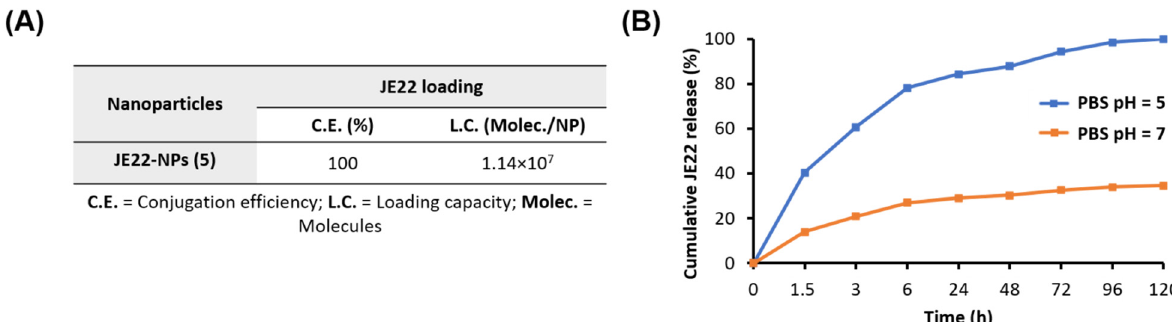
Figure 4. Evaluation of drug loading and release from JE22-NPs ( 5 ). ( A ) Determination of CE and LC of JE22 per nanoparticle. ( B ) Cumulative JE22 release. JE22-NPs ( 5 ) were incubated for 120 h in PBS at pH = 5 and pH = 7 at 37 °C. Results are expressed with the values of the mean ± SEM.